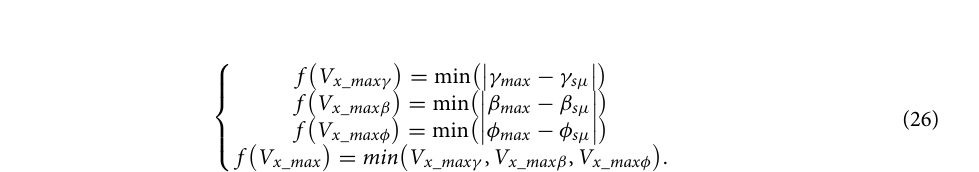
Figure 1. The extreme speed at different road adhesion coefficients and wheel